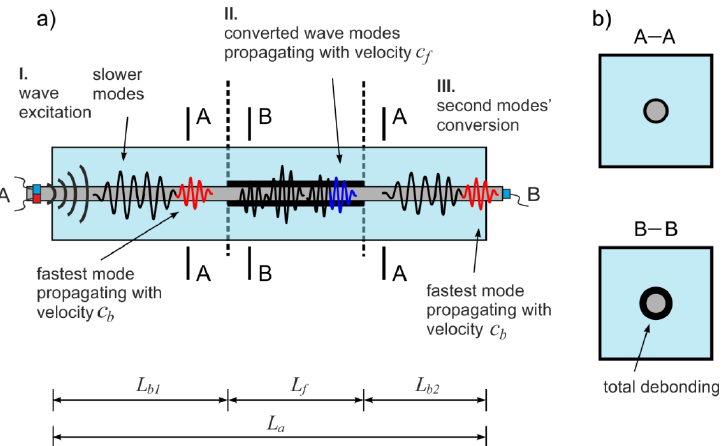
Figure 3. Wave propagation in RC beam with partial debonding damage: ( a ) Scheme of the phenomenon of wave modes’ conversion, ( b ) types of cross-sections.